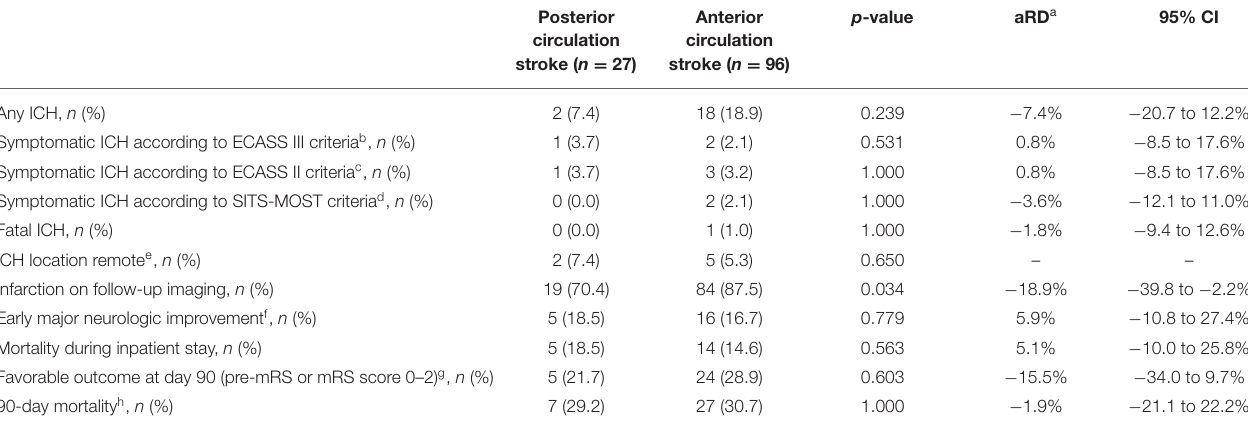
TABLE 7 | Outcomes in the large vessel occlusion patient cohort.